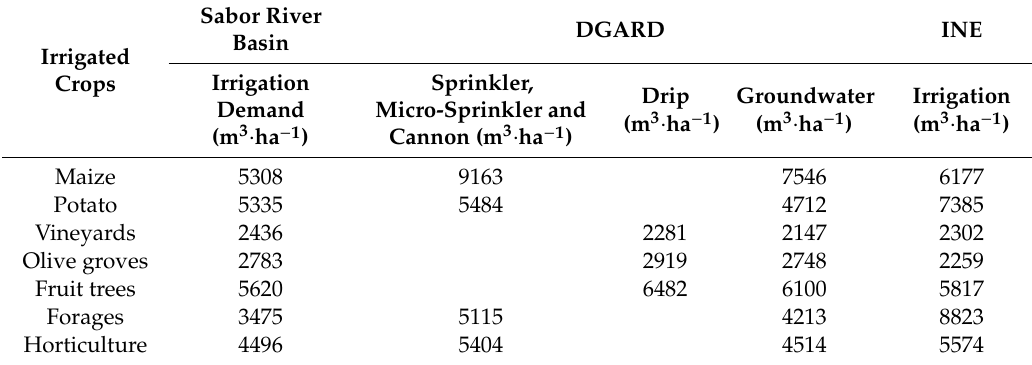
Table 6. The irrigation demand in the Sabor River basin and the reference irrigation allocation for each crop. The simulation was performed at the sub-catchment scale and for the period 1960–2008. The reference irrigation allocation for each crop was obtained from the Directorate-General for Agriculture and Rural Development (DGARD) [55] and Statistics of Portugal (National Statistics Institute, INE) [17]. The DGARD provides a reference irrigation allocation for groundwater and for di ff erent surface irrigation methods. We used an average of the sprinkler, micro-sprinkler, and cannon irrigation methods for the maize, potato, forages, and horticulture crops, and the drip irrigation method was used for the vineyard, olive grove, and fruit tree crops. The reference irrigation allocation from (DGARD) is for the Northern and Central Interior Region of Portugal, and the reference irrigation allocation from Statistics Portugal is for